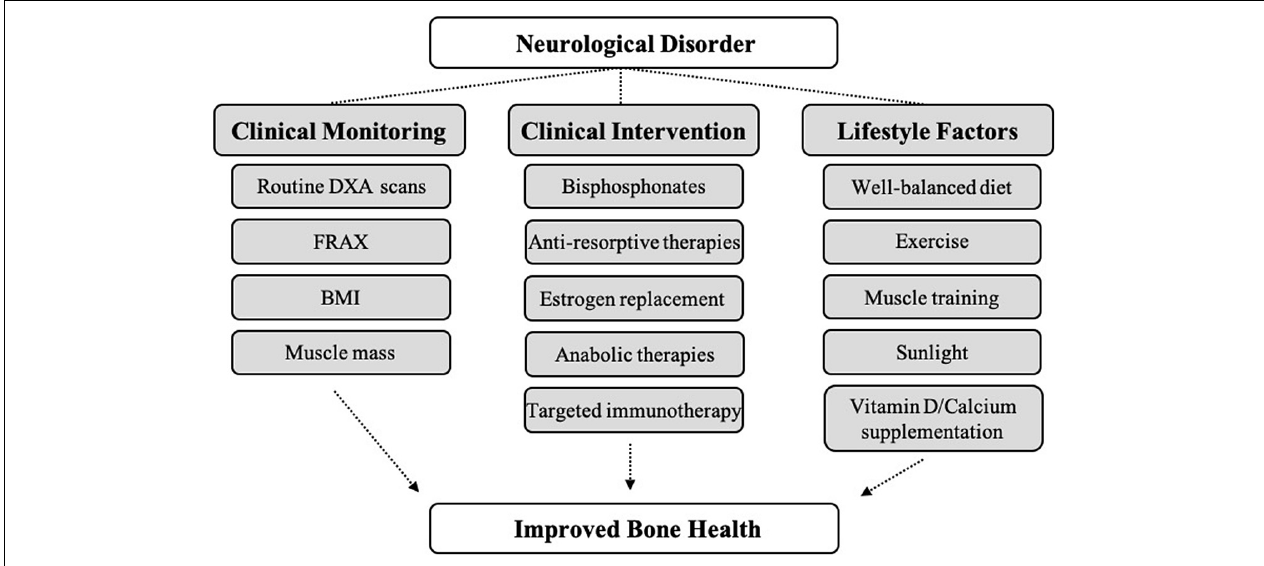
FIGURE 1 | Proposed methods to improve bone health in patients with neurological disorders. There is considerable clinical evidence demonstrating negative impacts of neurological diseases on bone across many disease categories. Patients with neurological diseases exhibit decreased BMD, as well as increased risk for osteoporosis and fracture. Careful clinical monitoring, clinical intervention, and positive lifestyle changes may lead to better bone outcomes in certain subsets of neurological disease